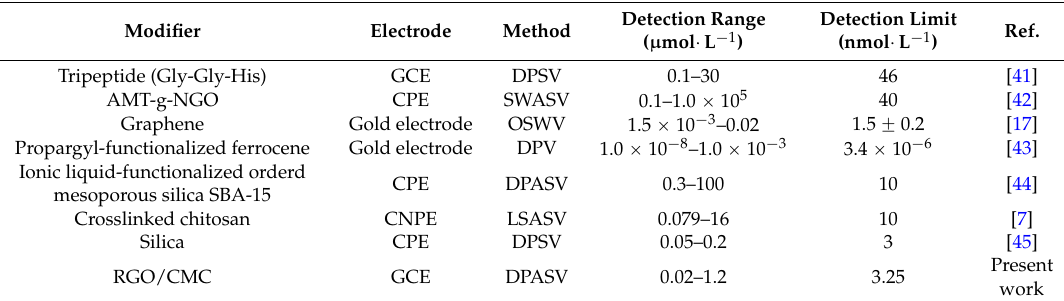
Table 4. Comparison of different modified electrodes for detecting Cu(II).